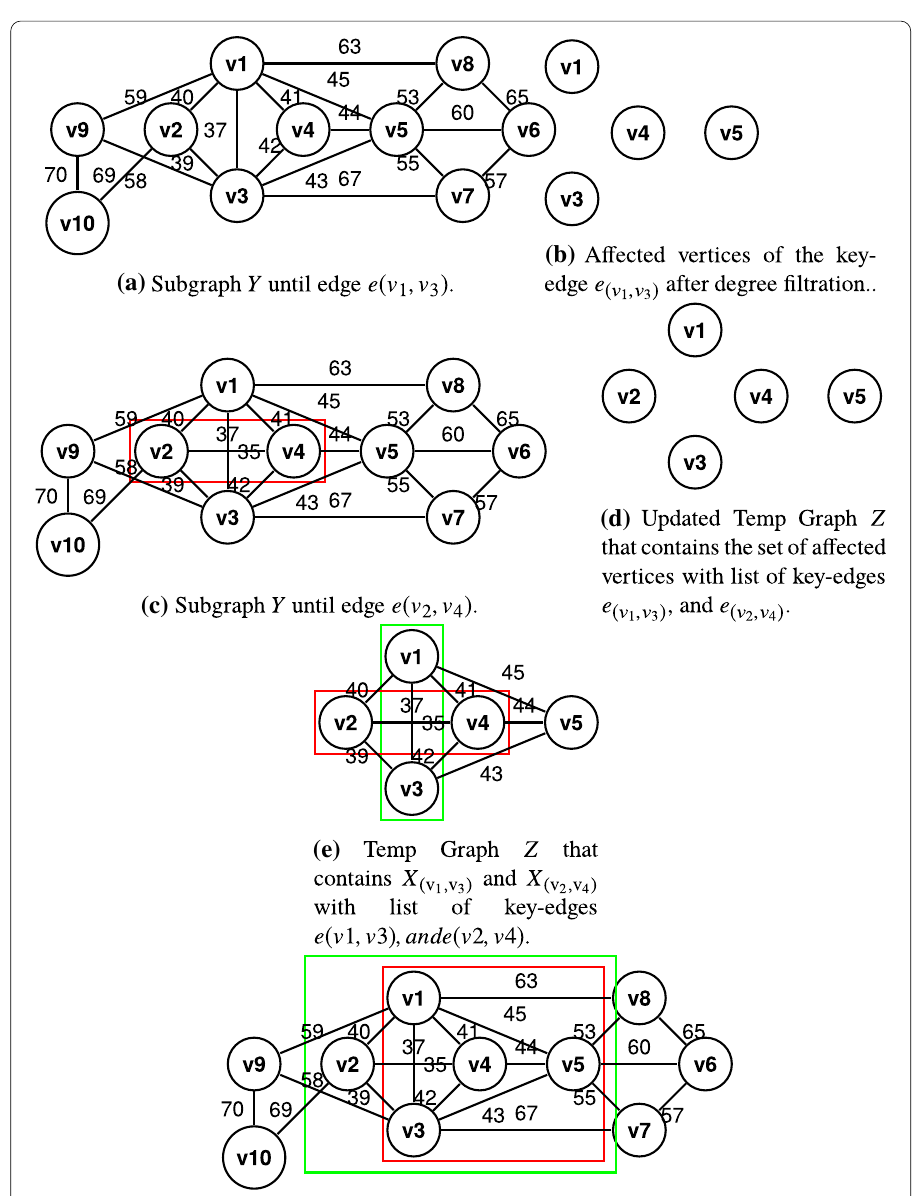
Fig. 6 Running example for